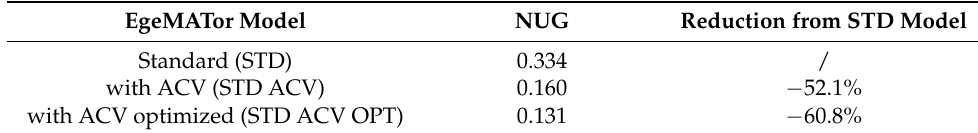
Table 1. Results summary at 1500 rev/min and 230 bar.